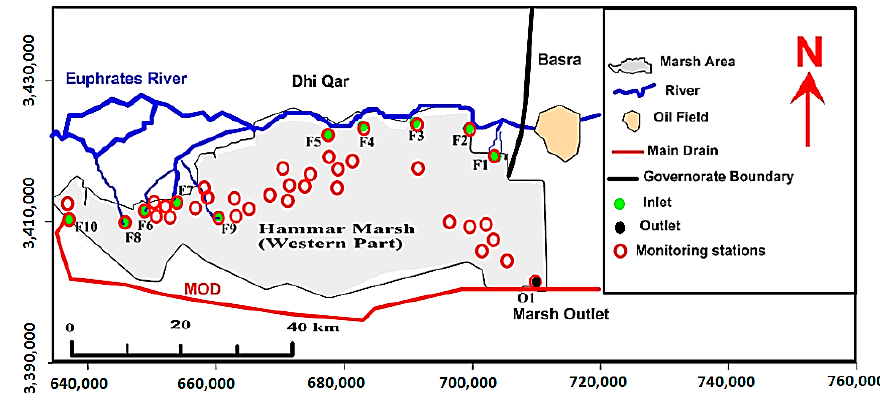
Figure 4. Locations of the measurement positions. Table 4. Flow velocity, water depth, and total dissolved solids (TDS) within the marsh (measured on 27 May 2015 and 28 May 2015). Point No.